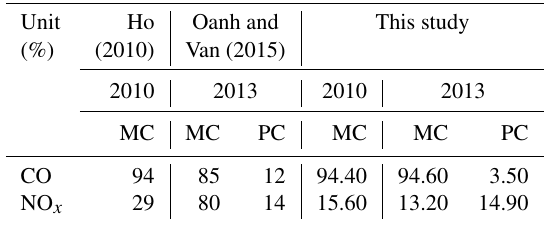
Table 14. Comparison of sharing ratios of emissions from MCs and personal cars (PCs) in this study and previous studies for 2010 and 2013 (unit: